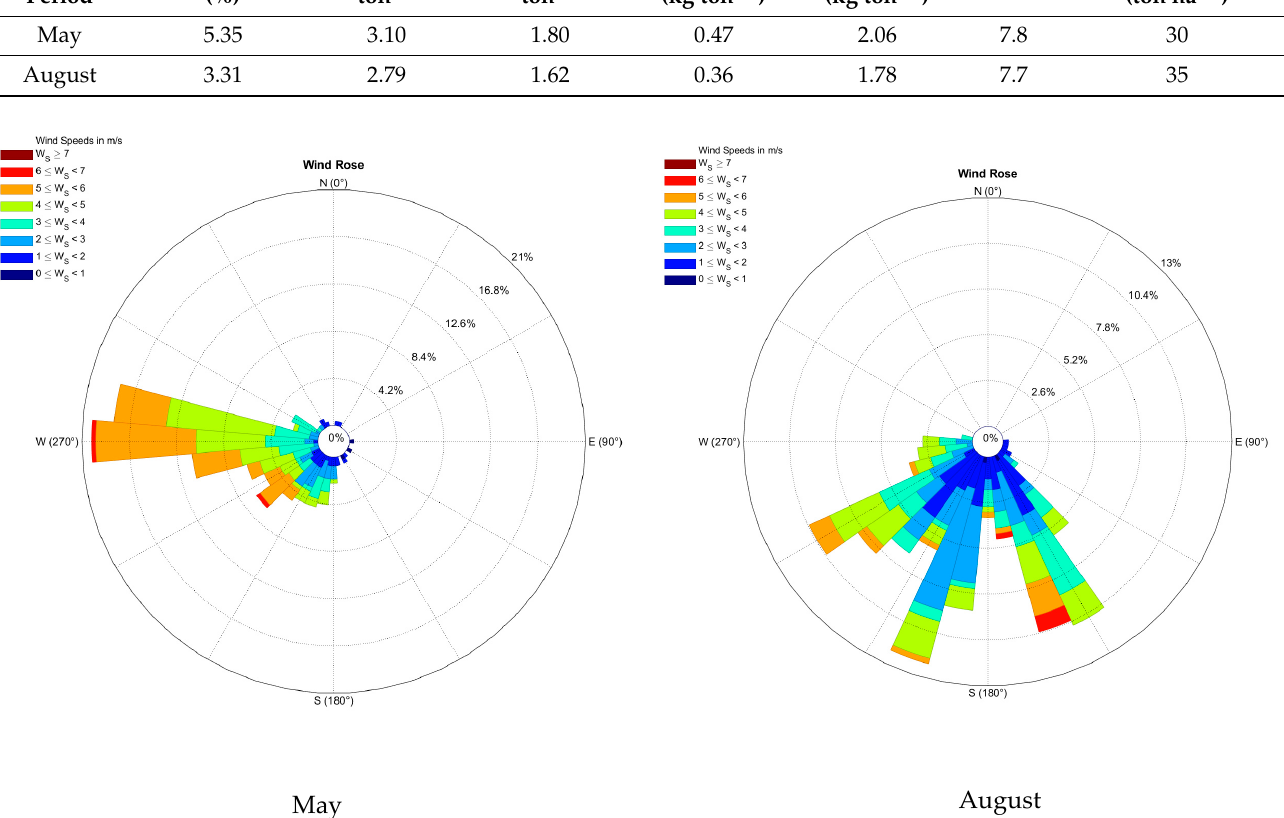
Table 1. Slurry composition in May and August of the digested slurry from a biogas plant. Figure 1. Overview of the field and measurement location on the field. The colored area is the 26- ha field where slurry was applied. MD-W and MD-E are the differential optical absorption spec- troscopy (miniDOAS) located west and east, respectively, the tower includes the micrometeoro- logical measurements and point concentration measurement of ammonia (NH 3 ) with cavity ring- down spectroscopy (CRDS).